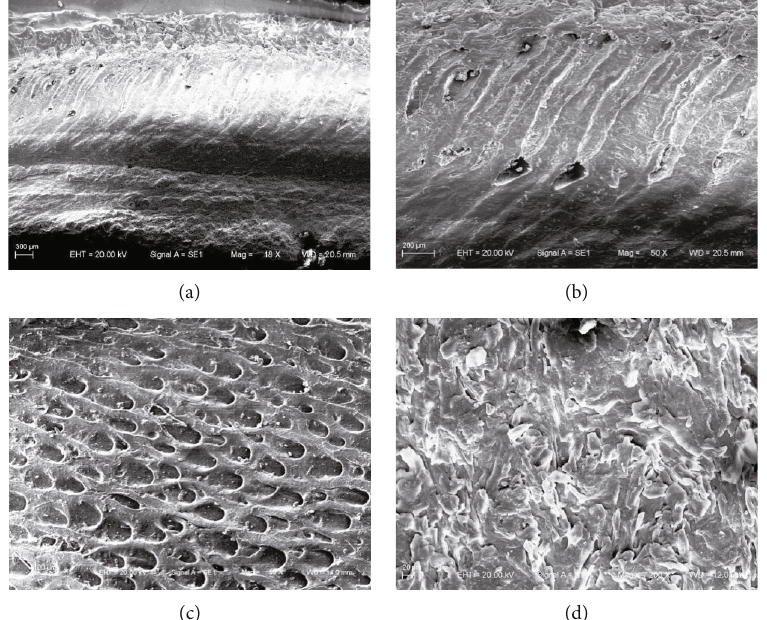
Figure 2: SEM images of hoof bulb tissues. (a) Longitudinal sections of bulb tissues; (b) longitudinal sections of the dermal layer; (c) cross- sections of the dermal layer; (d) cross-section of the epidermal